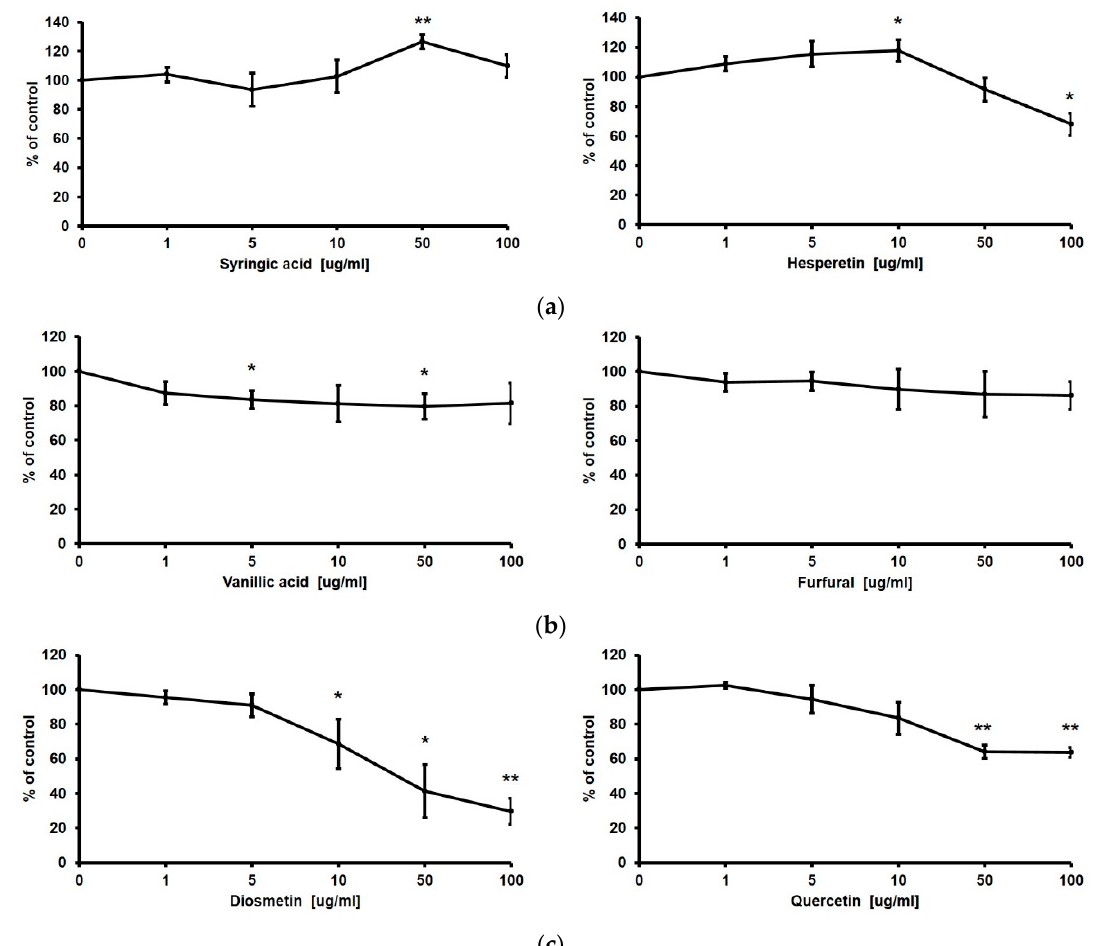
Figure 8. Proliferative effect of constituent compounds of TK extract on HaCaT cells. HaCaT cells were treated with indicated concentrations of syringic acid and hesperetin ( a ), vanillic acid and furfural ( b ), and diosmetin and quercetin ( c ). The cell viability was evaluated with an MTT assay. (*: p < 0.05, **: p < 0.01.)